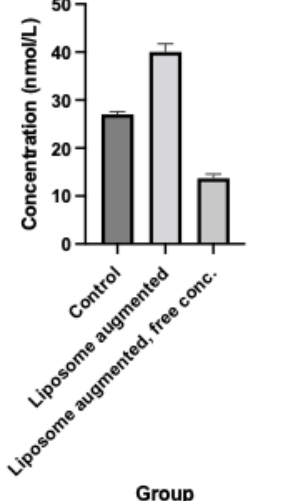
Figure 2. Amitriptyline concentrations by group, in vitro experiment.